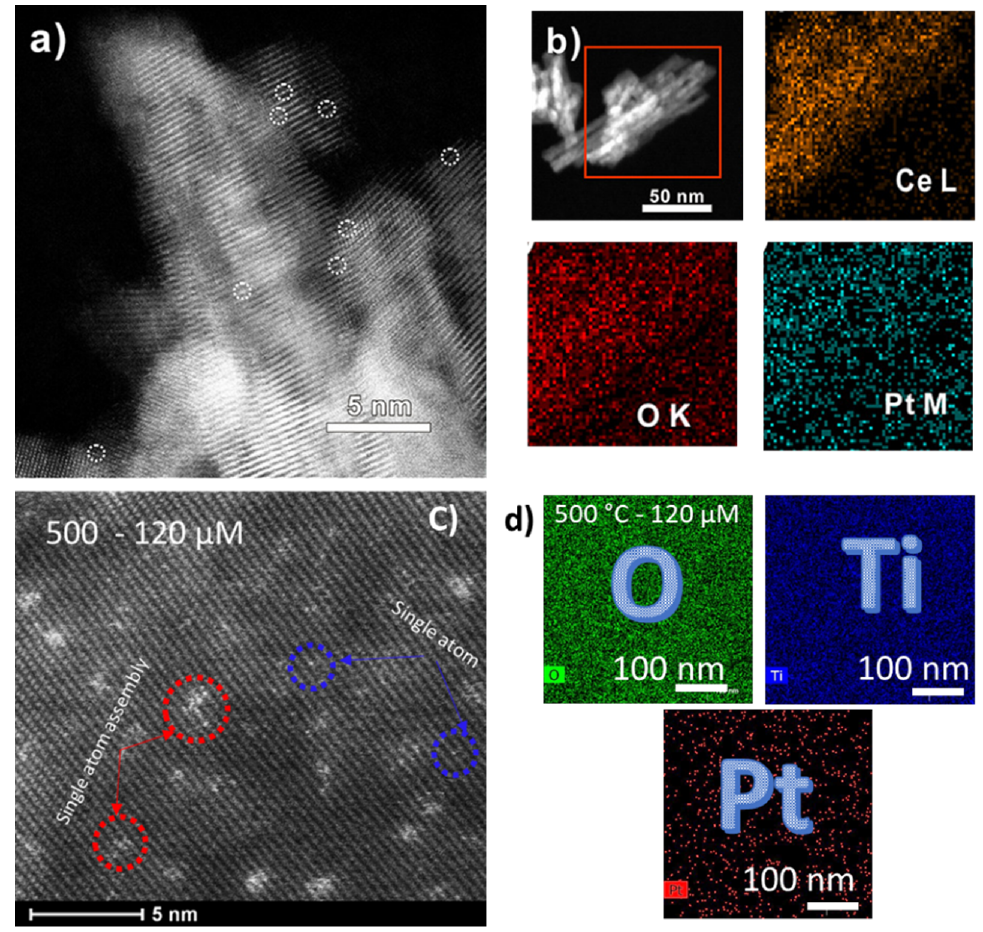
Figure 3. Pt on CeO 2 : ( a ) Cs-corrected HAADF-STEM, ( b ) HAADF-STEM, and corresponding elemental mappings images of CeO 2 -AA-Pt-cal. ( c , d ) Pt on TiO 2 : ( c ) HAADF-TEM image and ( d ) EDS